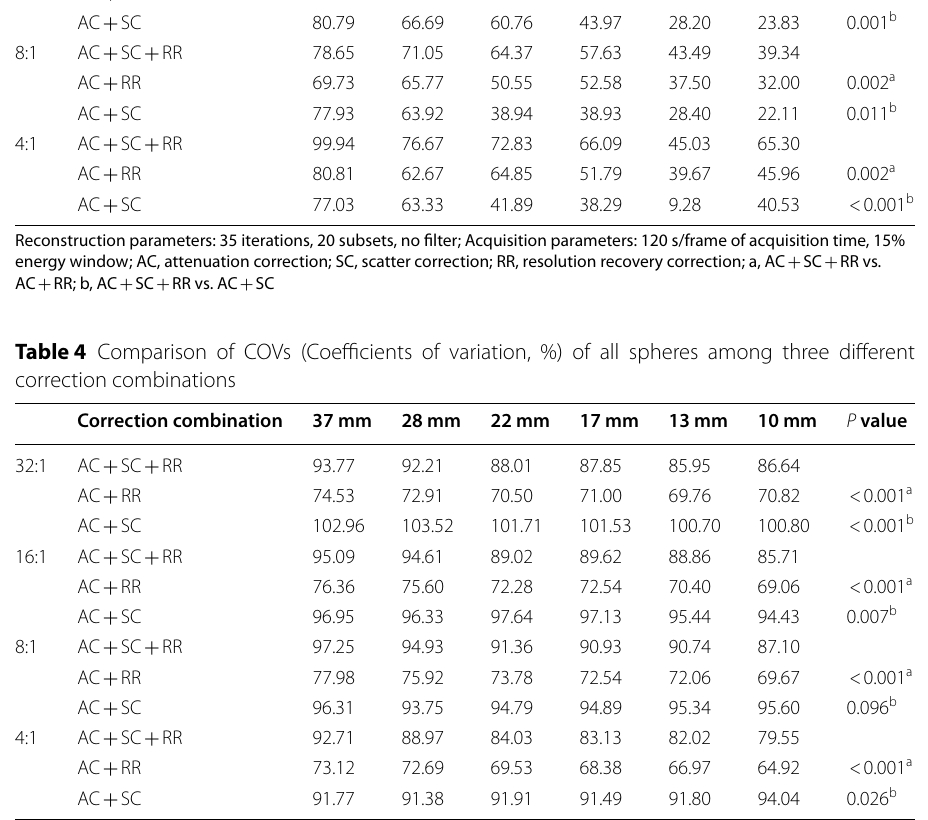
Table 5 Comparison of RCs (%) between the 15% energy window and 20% energy window